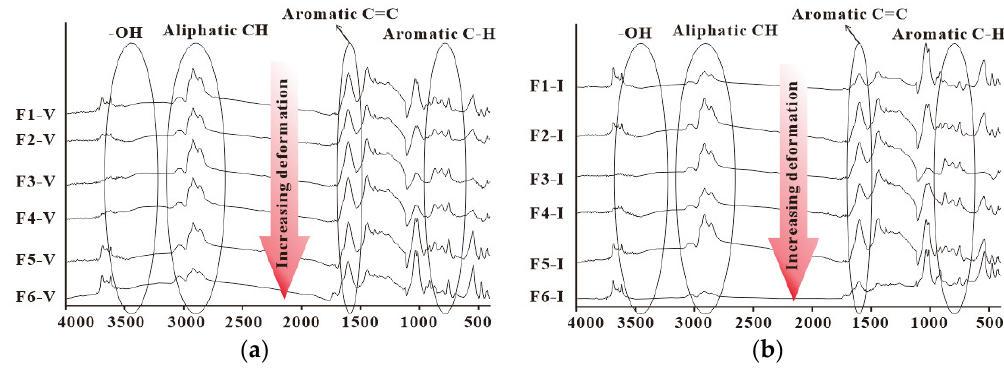
Figure 11. FTIR spectrum of vitrinite ( a ) and inertinite ( b ).